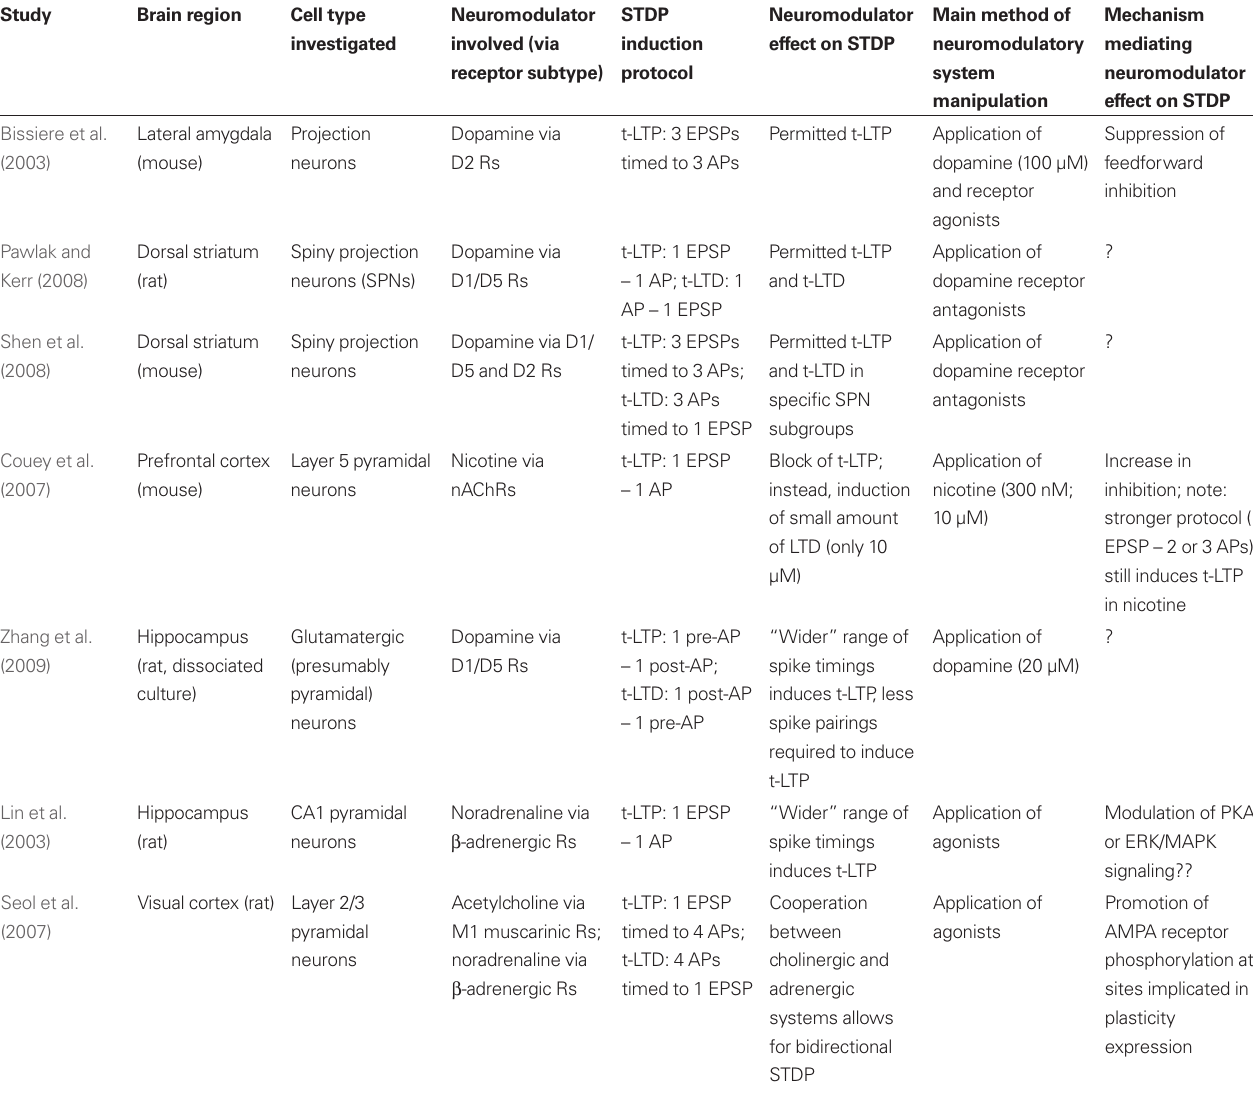
Table 1 | Comparison of studies investigating the effect of neuromodulators on STDP.